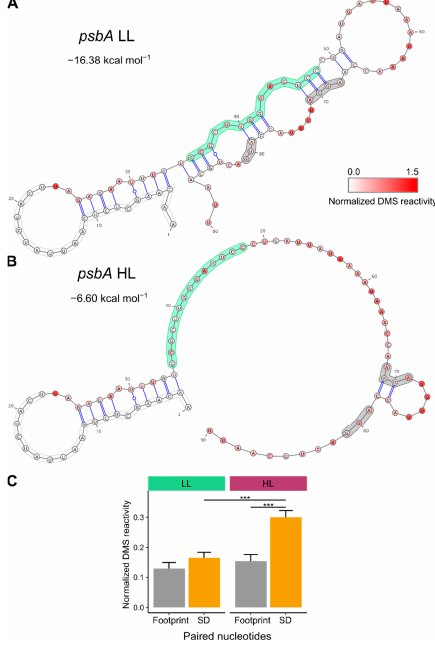
Figure 2. Footprint of a putative regulatory protein bound to the 5 (cid:48) UTR of psbA : ( A ) Predicted mRNA secondary structure of the psbA translation initiation region in low light (LL) using normalized DMS reactivities (Figure 1A) as constrains. The white box marks the position of the primer used to amplify the cDNA. For this region no DMS reactivities could be obtained. The green box marks the footprint of a RNA binding protein [36] (Supplemental Figure S11A–D), the grey boxes indicate the Shine- Dalgarno sequence (AGGA) and the start codon (AUG). For each nucleotide, the normalized DMS reactivity is shown in a color code. The kcal mol − 1 value for the strength of the RNA structure is given. ( B ) Predicted mRNA secondary structure in high light (HL) using normalized DMS reactivities (Figure 1A) and the protein binding site (forced to be single-stranded) as constrains. For the structure predictions for in vitro-folded RNA see Supplemental Figure S11G. ( C ) Normalized DMS reactivities of the nucleotides predicted to form base pairs in low light ( A ) between the region of the footprint (between nucleotides 35–48) and the region including the start codon and the Shine-Dalgarno sequence (SD) (between nucleotides 69–86). The average normalized DMS reactivities are shown separately for both regions. Nucleotides in these regions predicted not to be paired are excluded. There is no significant difference between low light and high light for the low DMS reactivities at the footprint side, which can indicate both double-stranded RNA and a bound protein. In contrast, the DMS reactivities at the SD side significantly increase in high light indicating a shift to single-stranded RNA. This suggests that in low light a stem loop structure is formed ( A ), whereas in high light a protein is bound to the psbA translation initiation region making the SD and the start codon accessible ( B ). Asterisks indicate statistically significant changes ( p -values calculated with the Wilcoxon rank sum test; *** = p < 0.001), error bars indicate mean standard error. For the separately analyzed DMS reactivities at adenosines and cytidines as well as SHAPE reactivities see Supplemental Figure